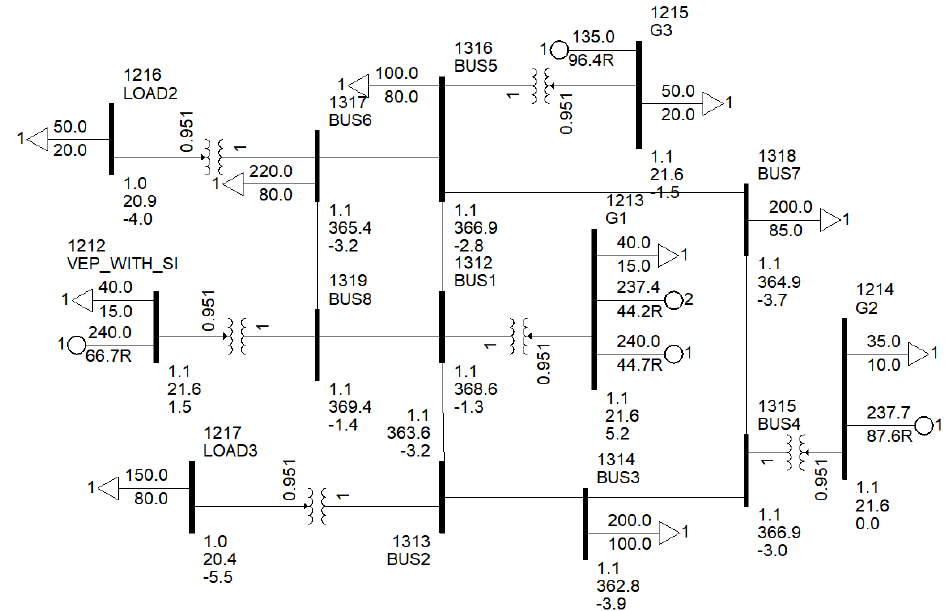
Figure 10. Single-line diagram of a system with a generating power source with the SI algorithm connected to 1212 busbars.